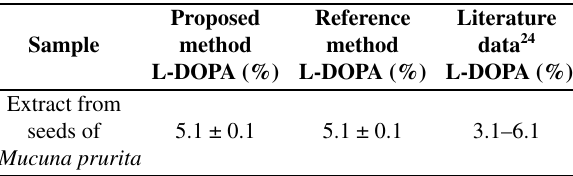
Table 1. Determination of the L-DOPA content in extract from the seeds of Mucuna